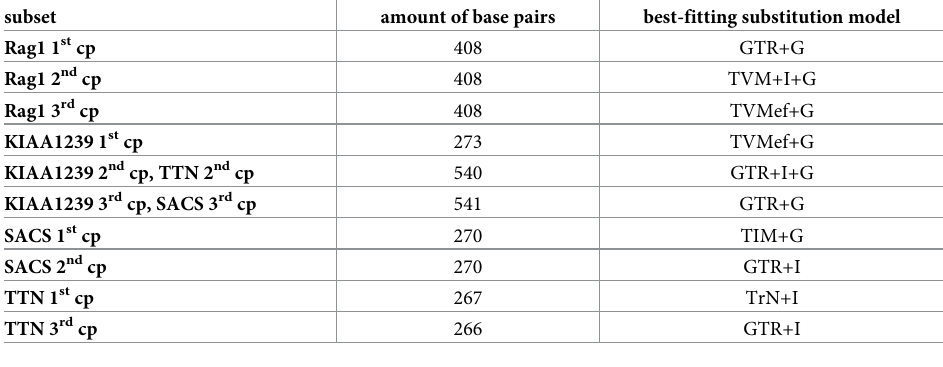
Table 2. Best-fitting partitioning schemes of defined subsets with models of nucleotide evolution.